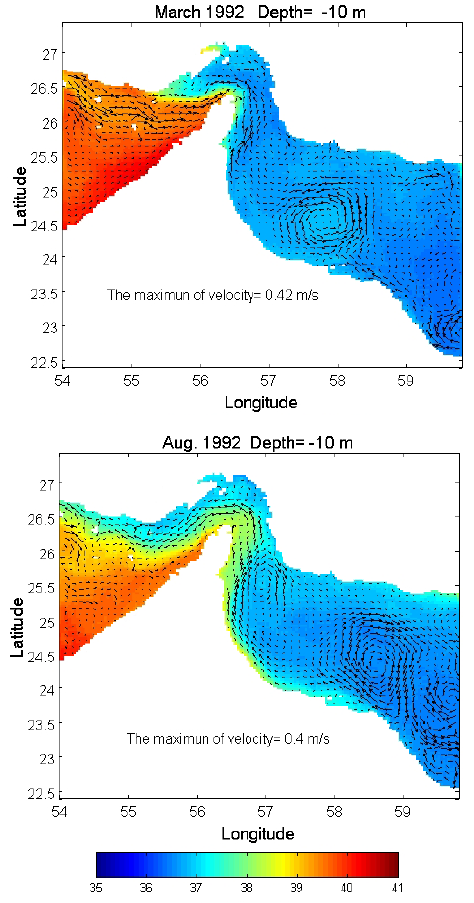
Fig. 14. The mean monthly of horizontal salinity and velocity fields at depth 10m for March (up) and August (down).